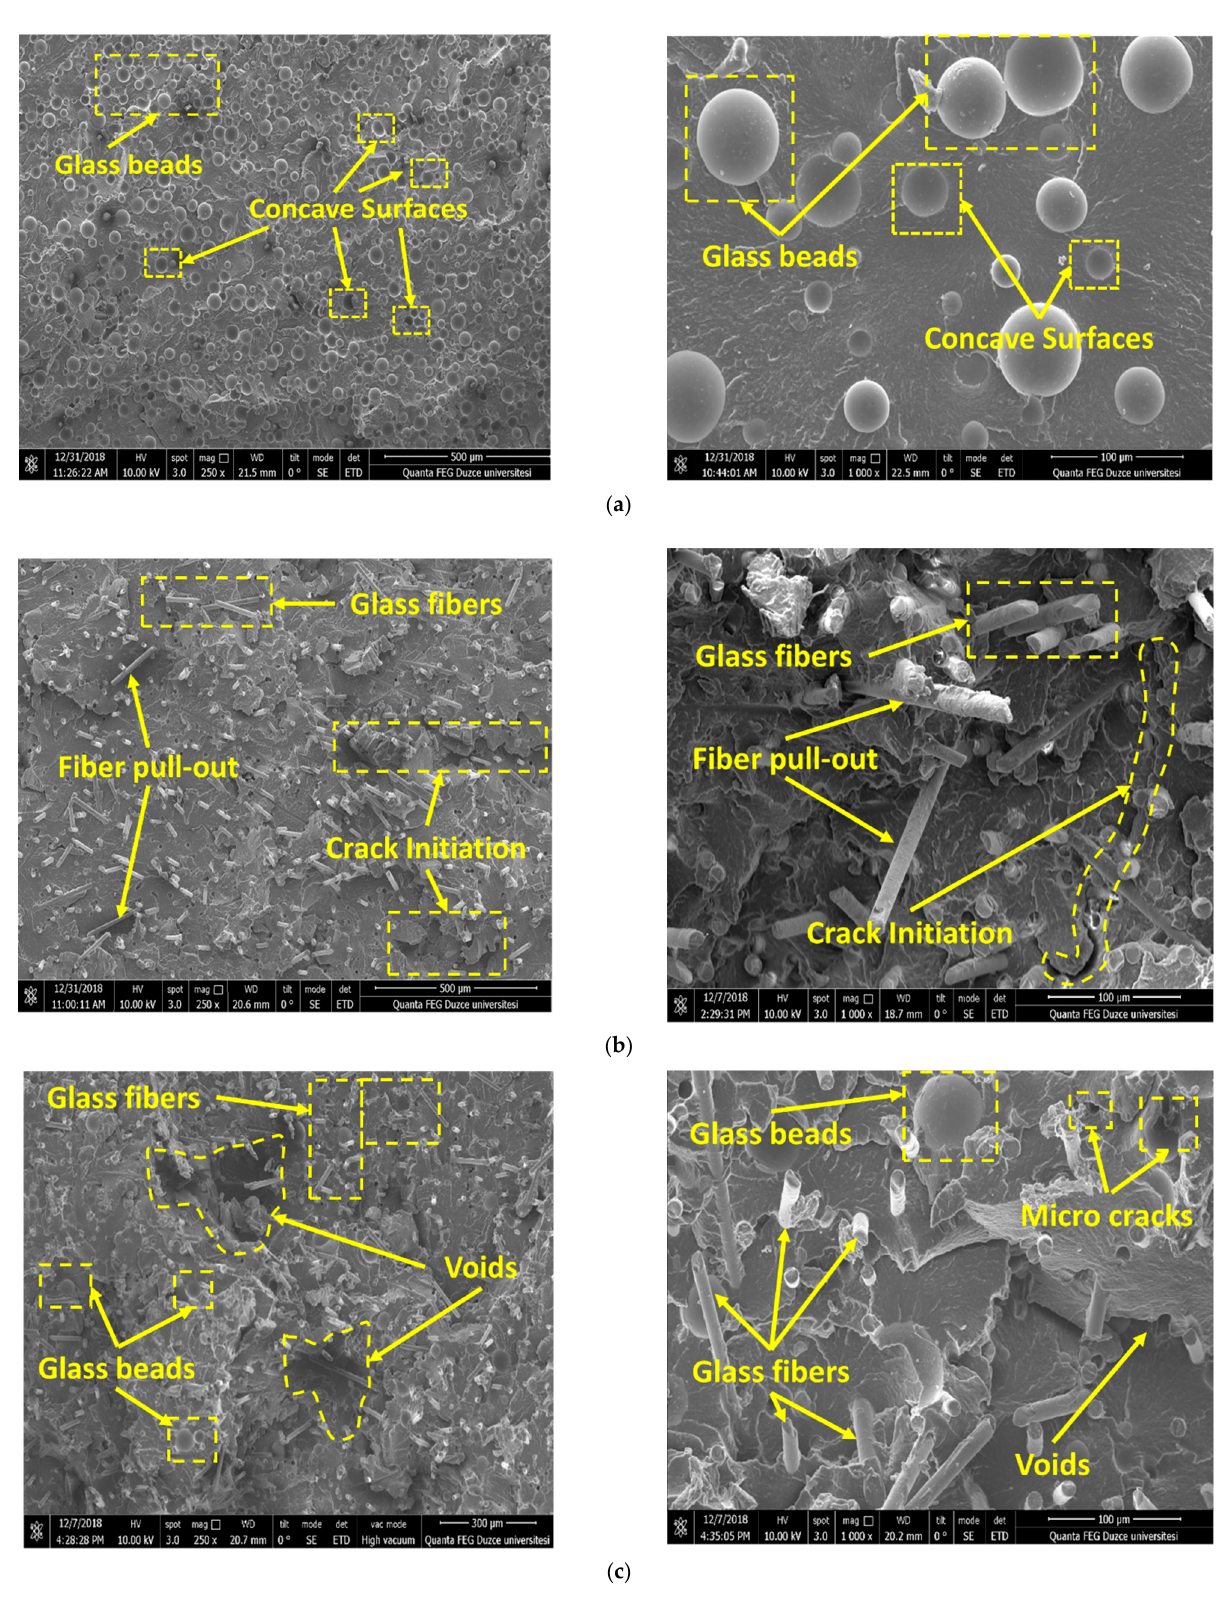
Figure 1. SEM views (250× to 1000× magnification) of composite materials with fractured surfaces ( a ) C1, ( b ) C2, ( c ) C3. ( a ) PA66 + 30% GB composite; ( b ) PA66 + 30% GF composite; ( c ) PA66 + 20% GF + 10% GB hybrid composite.